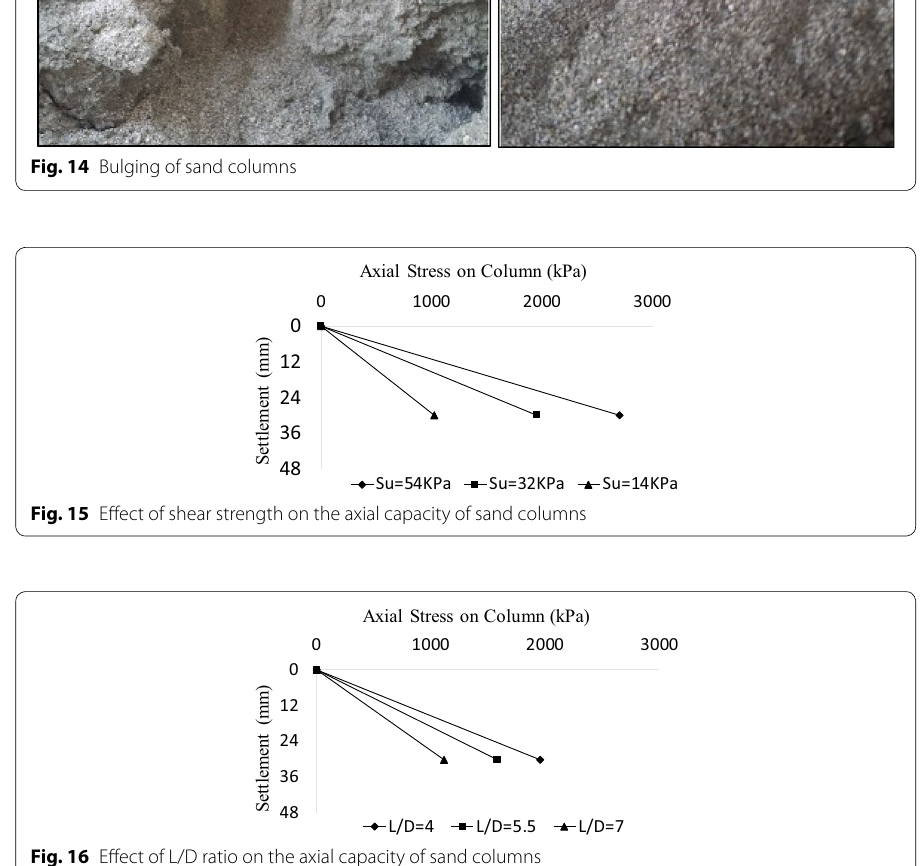
strength. The shear strength of clay significantly affects the axial capacity of the sand col- umn. The sand column showed the maximum axial capacity at relatively stiff clay i.e. at 54 kPa and minimum capacity at comparatively soft clay i.e. at S u S u =